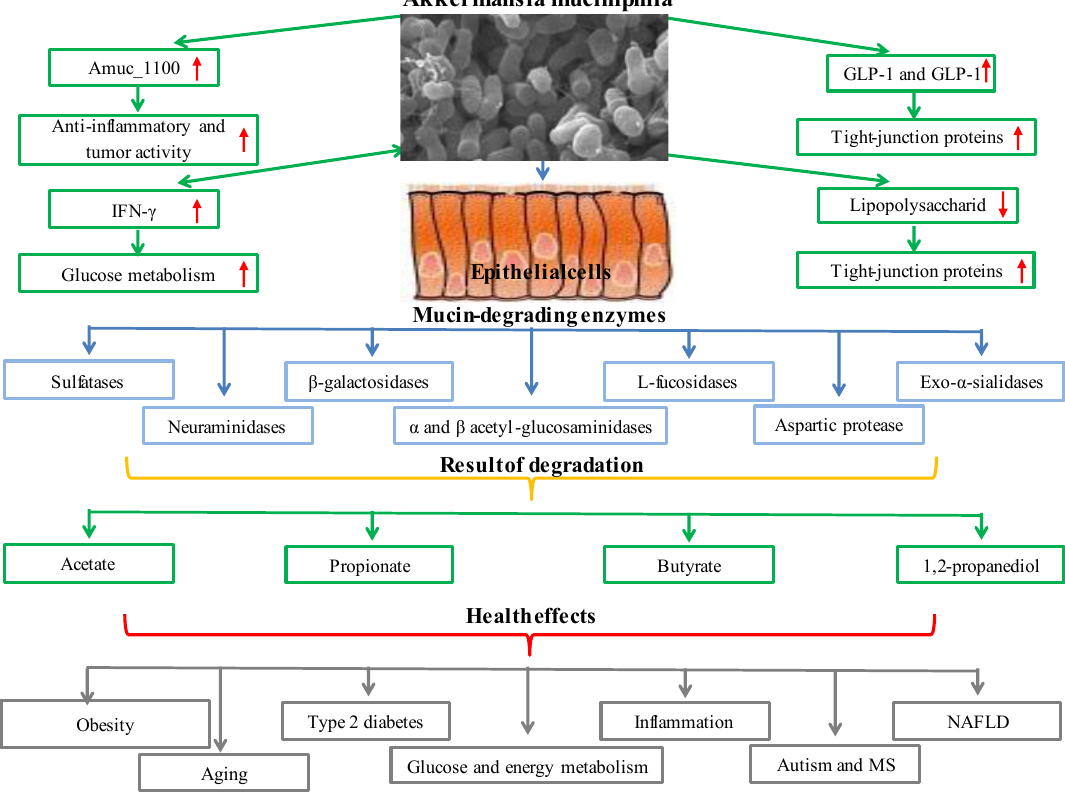
Figure 3. Metabolic functions and health effects of Akkermansia muciniphila .